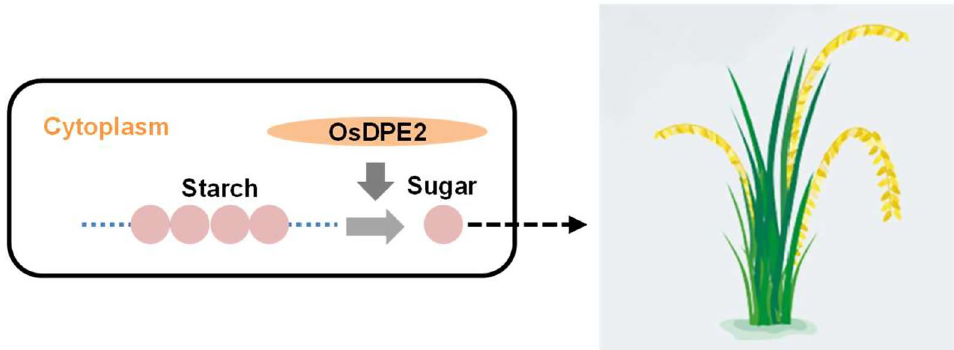
Fig. 7 Model of OsDPE2 regulating rice panicle morphogenesis. OsDPE2participates in starch breakdown, thus providing available carbon source for vegetative and reproductive plant development of